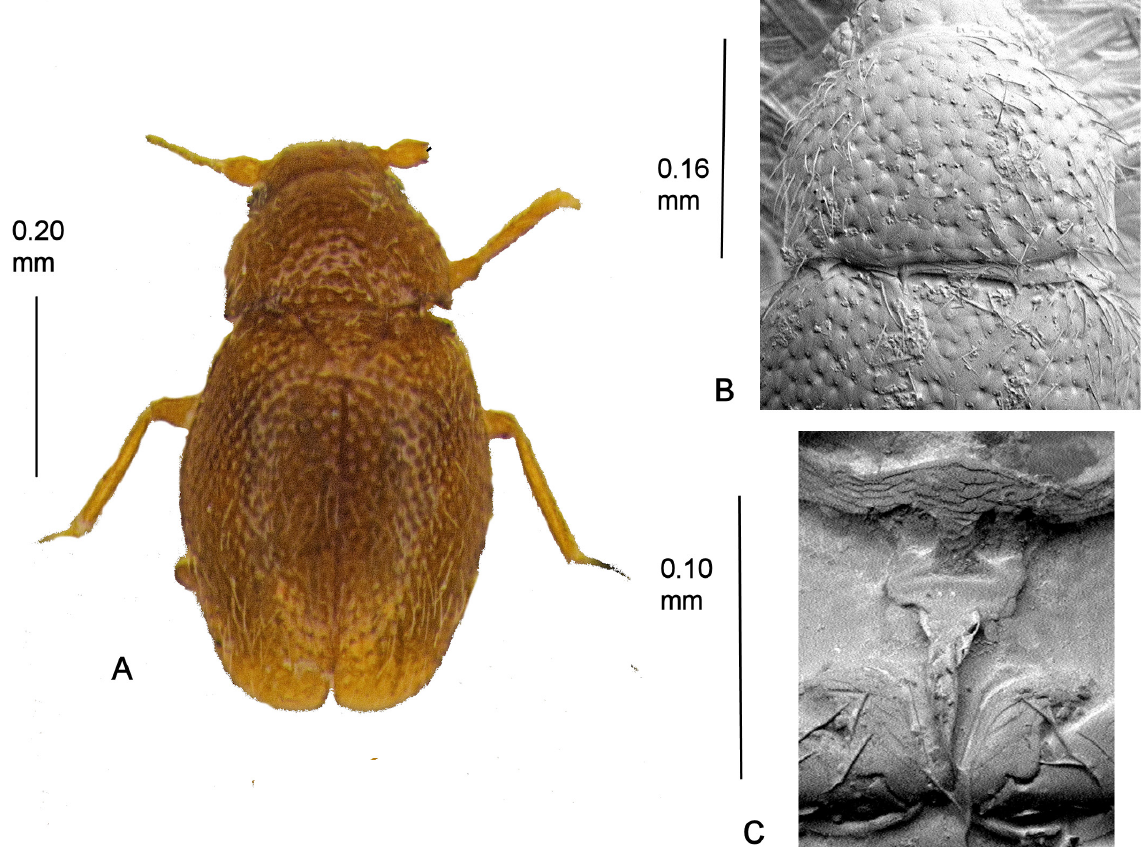
Fig. 54 . Cissidium mahleri sp. nov. A . Habitus. B . Pronotum, × 630. C . Mesoventrite showing median process of collar, mid-keel and keel,